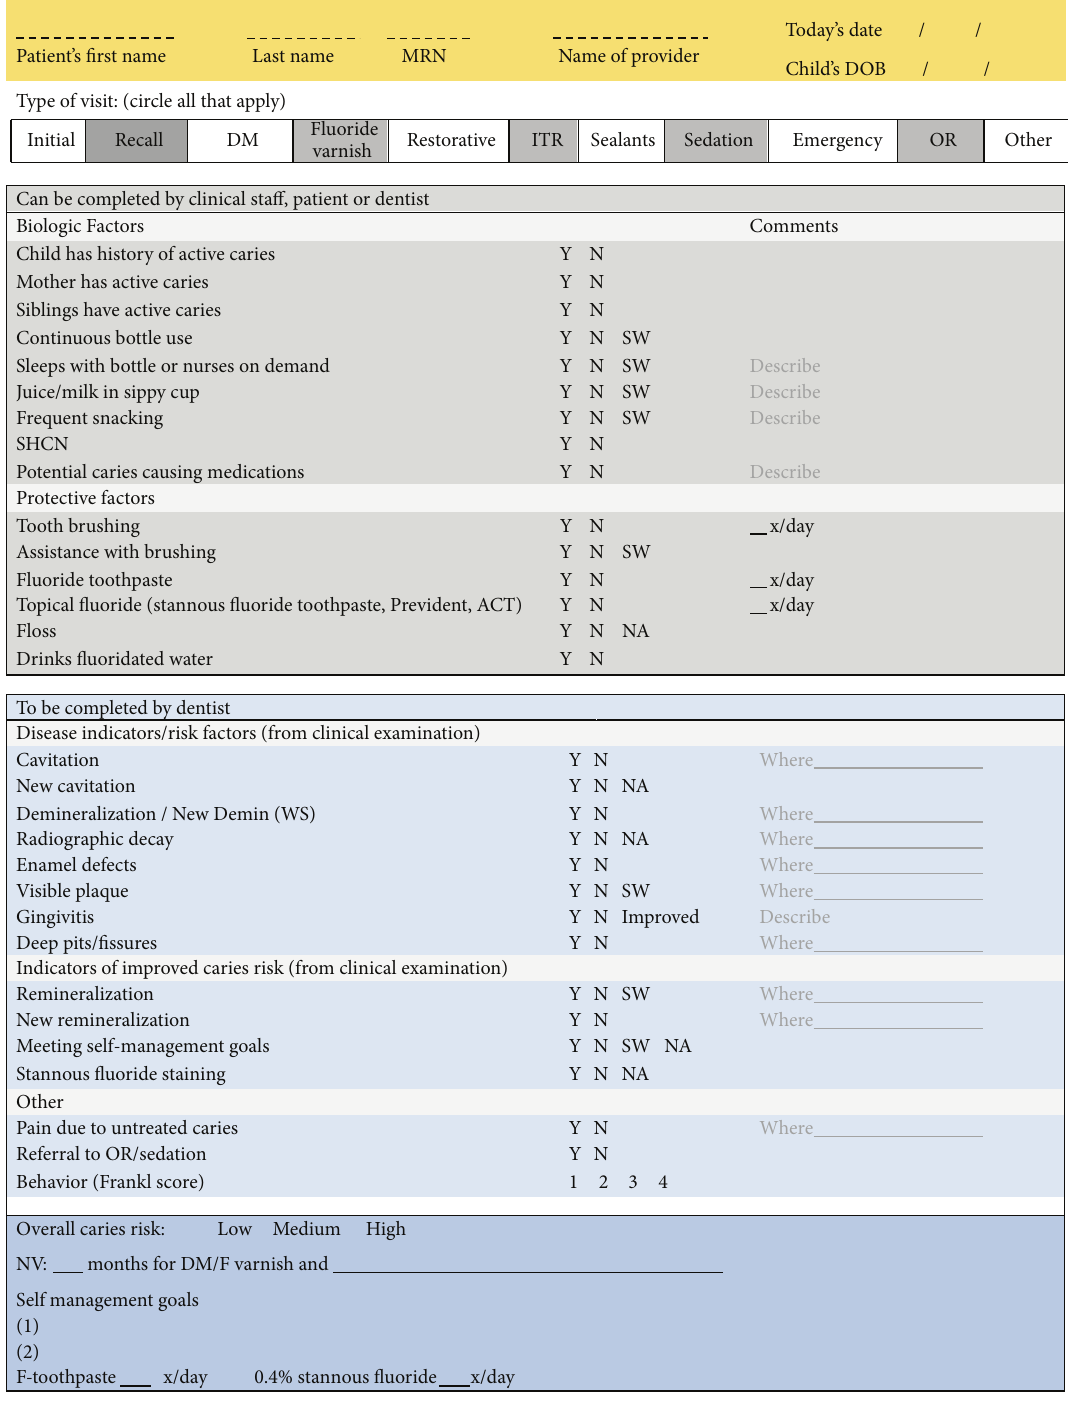
Figure 3: Sample ECC Phase 2 caries risk assessment